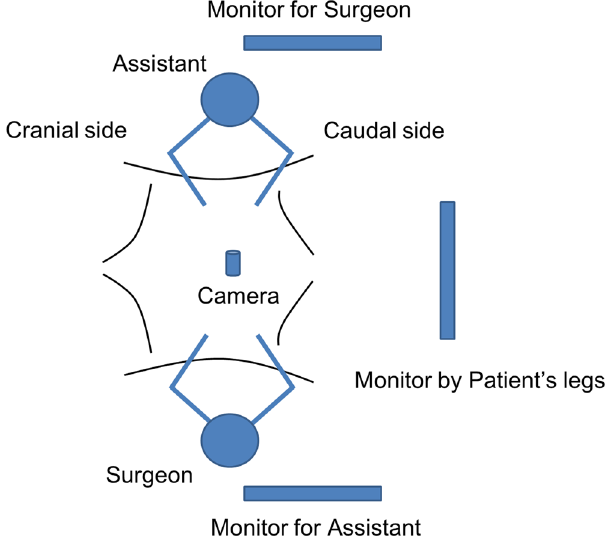
Figure 2. Usual setup for laparoscopic left-sided colorectal surgery. The surgeon usually stands on the right side of the patient and the assistant stands on the left side of the patient. The camera is placed through the umbilical port. The monitor for the surgeon is in front of the surgeon. The monitor for the assistant is in front of the assistant. A third monitor is placed by the patient’s legs.